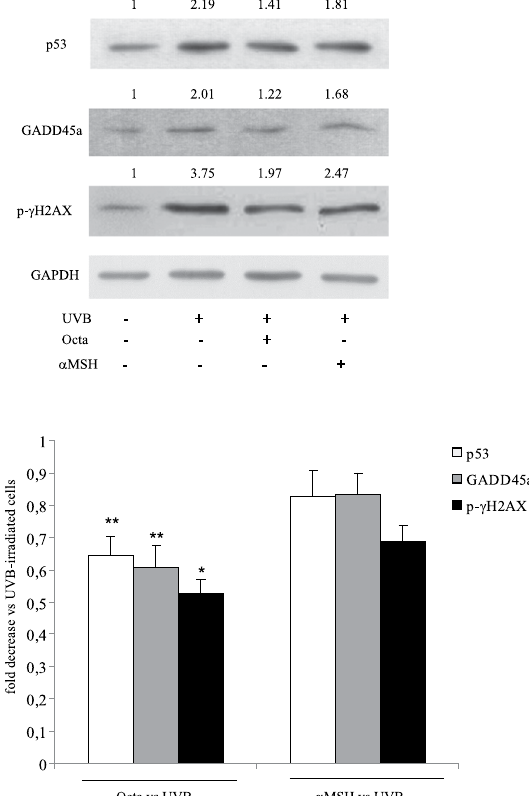
Figure 5. Photoprotective effect of Octa or α MSH in WT or MC1R loss of function NHKs. Western blot analysis of p53, GADD45a and phospho- γ H2AX protein expression on cell lysate of NHKs, WT or LOF (Arg 151 Cys, Arg 160 Trp, Asp 84 Glu) for MC1R , pre-treated with 90 µ M Octa or 10 − 7 M α MSH for 24 h and irradiated with UVB 25 mJ/cm2. Proteins were extracted 24 h later. GAPDH was used as a loading control. Representative blots are shown. Densitometric scanning of band intensities was performed to quantify the change of protein expression (control value taken as one fold in each case). The values reported represent means ± SD of three independent experiments. * p < 0,05 (vs α MSH-treated UVB-irradiated cells), ** p < 0,01 (vs α MSH-treated UVB-irradiated